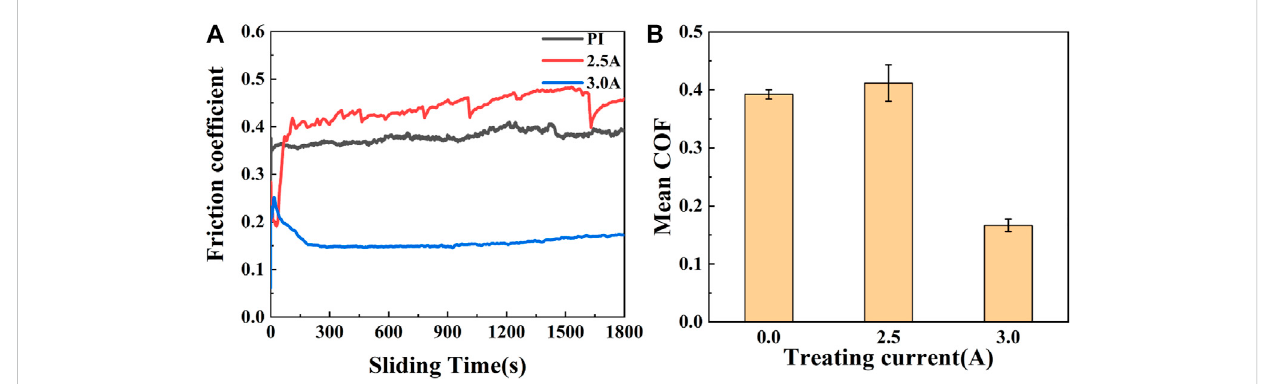
FIGURE 11 The friction coef fi cient of the PI substrates treated with different graphite target currents with loads of 8N: (A) the friction coef fi cient curve (B) the average friction coef fi cient and the wear rate.